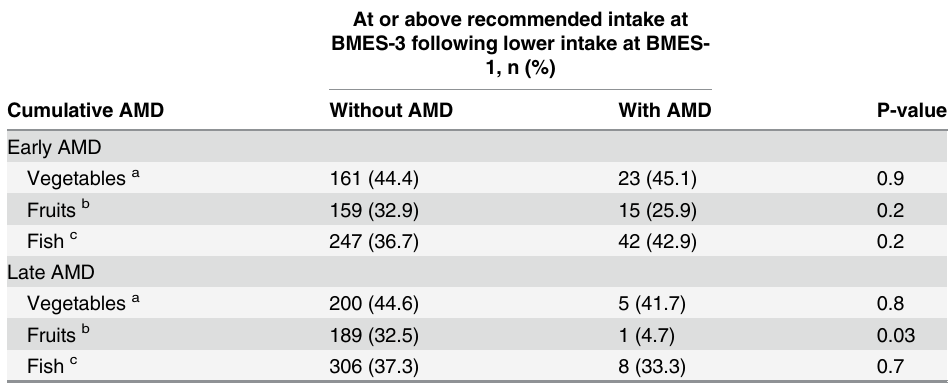
Table 3. Association between cumulative cases of AMD and increase in consumption of fruits, vege- tables (in g/day), and fish over 10 years in the Blue Mountains Eye Study. At or above recommended intake at BMES-3 following lower intake at BMES- 1, n (%) Cumulative AMD Without AMD With AMD